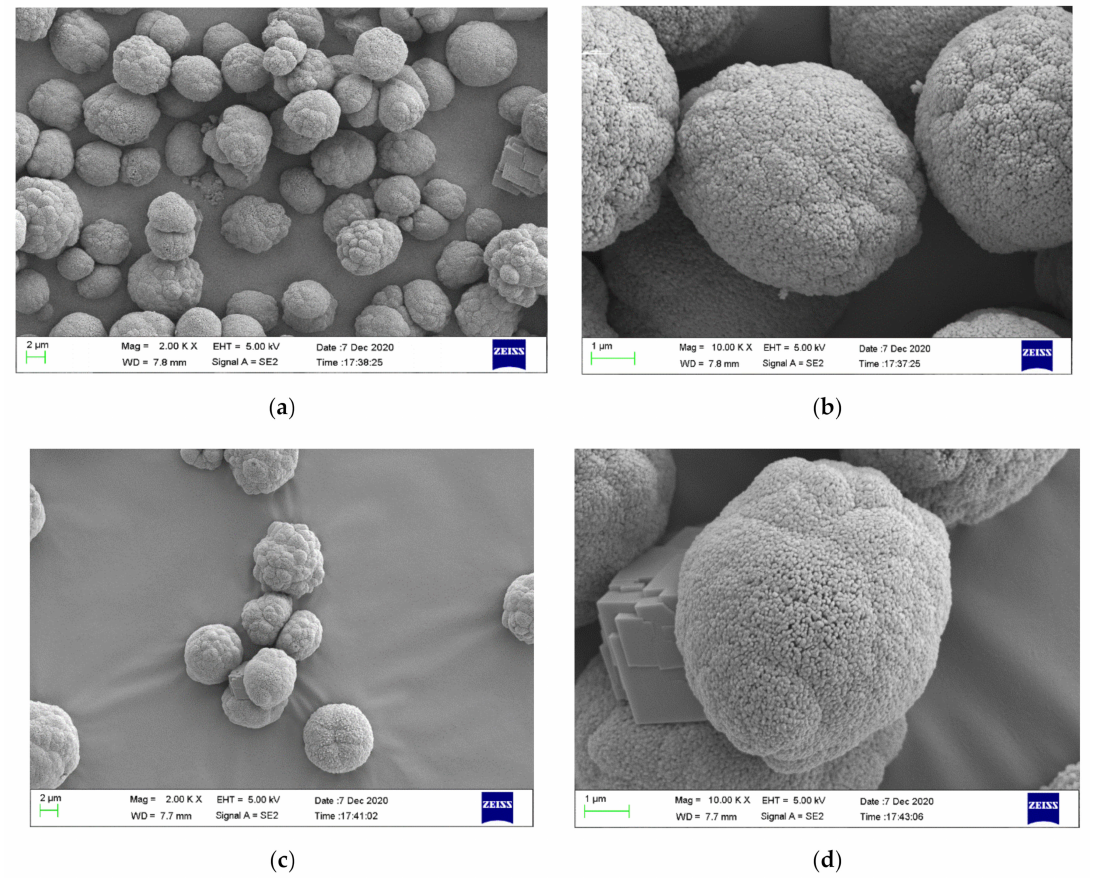
Figure 2. SEM images of ( a ) CaCO 3 microparticles, ( b ) CaCO 3 microparticles at higher magnification, ( c ) CaCO 3 microparti- cles loaded with sodium lignosulfonate (SLS), and ( d ) CaCO 3 microparticles loaded with SLS at higher magnification.